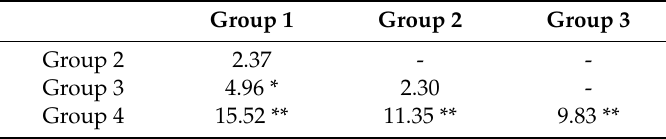
Table 2. Pairwise post hoc comparisons of purpose in life score among the